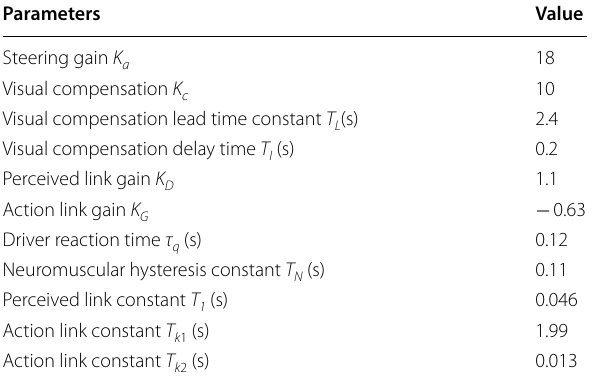
Table 1 Driver model parameters